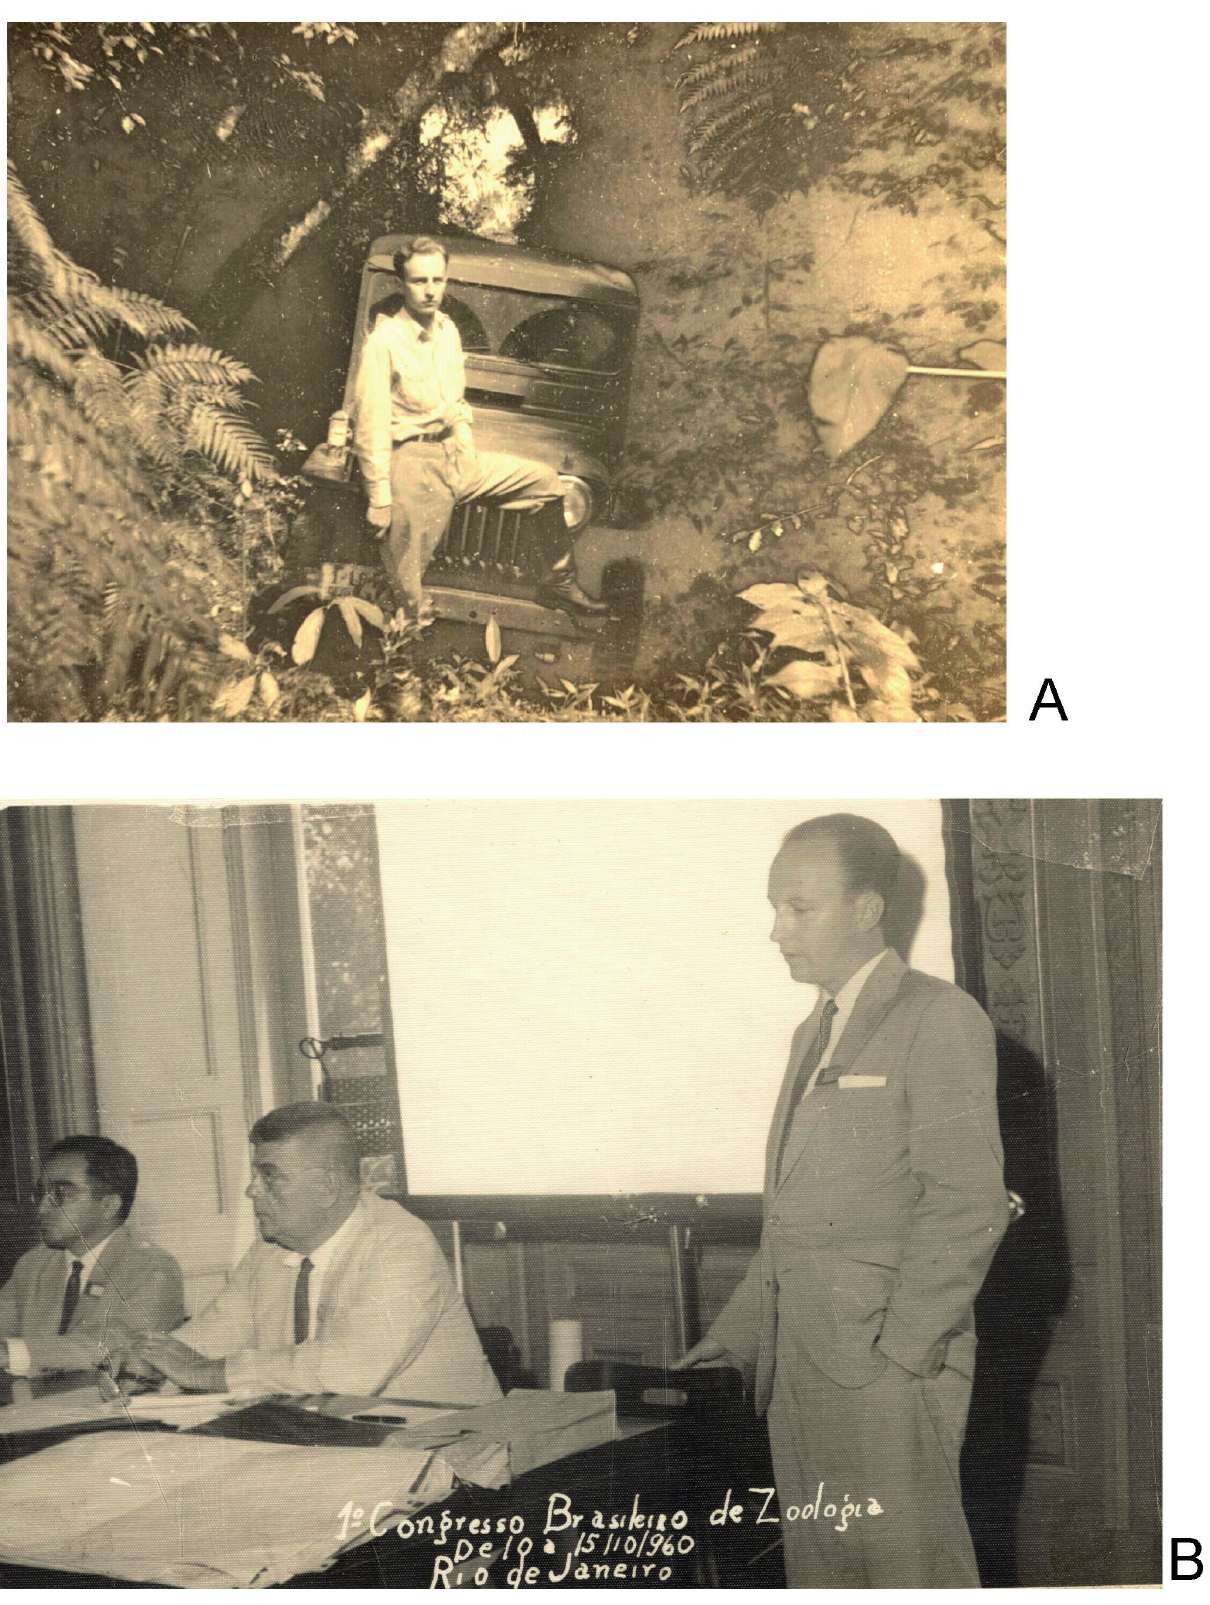
Figure 1. Ludwig Buckup in the beginning of his career. A, As a student, in a field trip (1952); B, During the I Brazilian Congress of Zoology, Rio de Janeiro, 1960. Photographs of L. Buckup’s personal